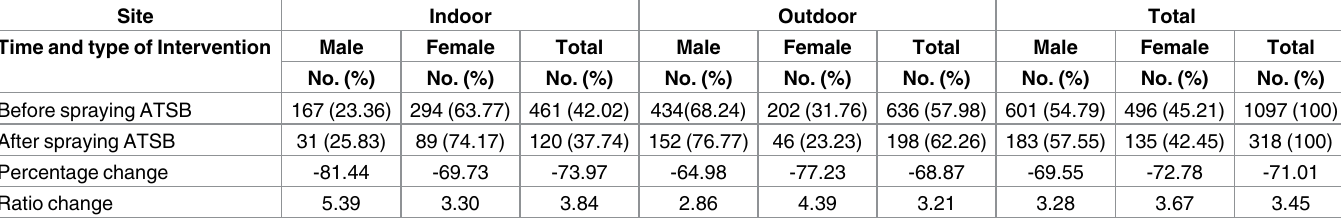
Table 2. The comparison of P . papatasi frequency with sticky traps before and after treatment in Jafar-Abad, Markazi district, Qom province, 2014–2015. Site Indoor Outdoor Time and type of Intervention Before spraying ATSB After spraying ATSB Percentage change Ratio